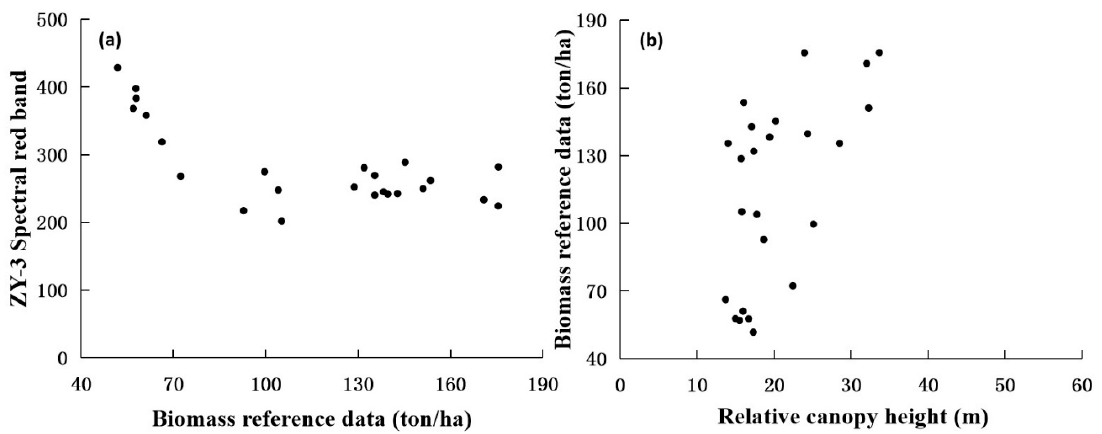
Figure 5. A comparison of the relationships ( a ) between aboveground biomass and spectral red band and ( b ) between aboveground biomass and relative canopy height.